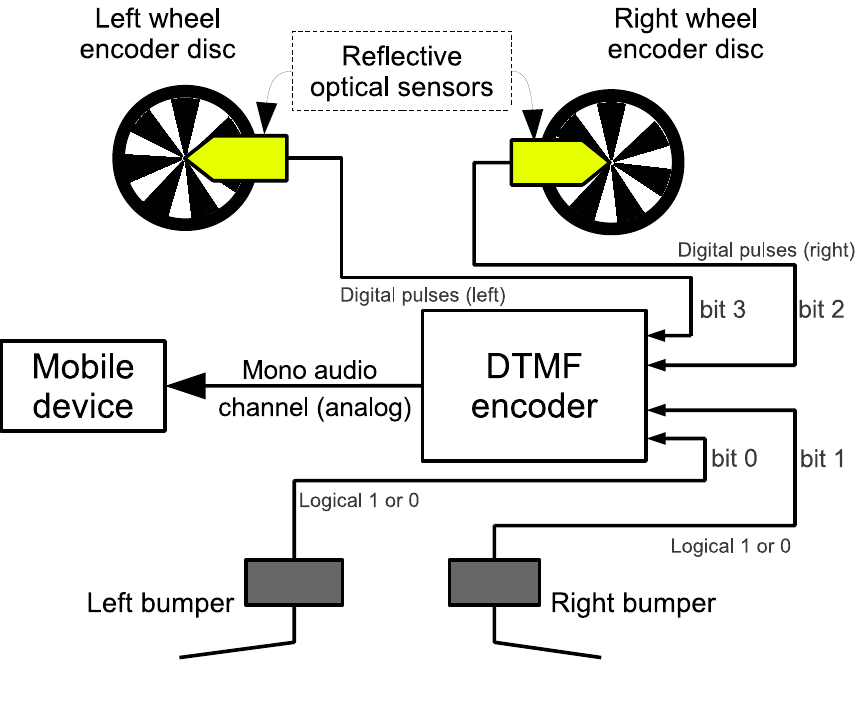
Figure 5. Sensors connection in a mobile robot with differential